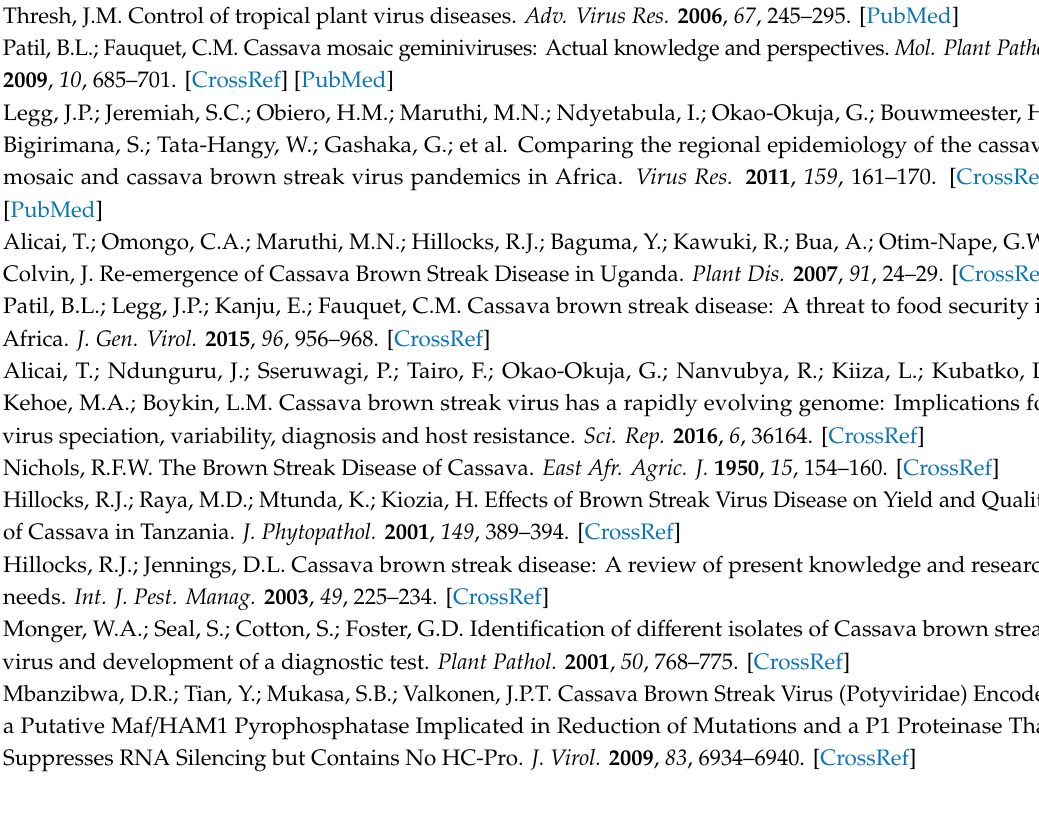
Table S1: Primer sequences used for CBSV and UCBSV detection by qPCR (upper half) and RT-PCR (bottom half) in leaves and storage roots of Ghanaian cassava cultivars. Figure S1: Map showing location of cassava fields from which leaf samples were collected for CBSD screening. Figure S2: PCR screening of eleven selected field-grown cassava cultivars in Ghana. Figure S3: Homology of primers used for RT-PCR screening of cassava cultivars and leaf material collected from farmers’ fields in Ghana. Figure S4: PCR screening of eleven selected cassava cultivars grown in Ghana for cassava mosaic geminiviruses. Table S2: Top-cleft graft transmission of CBSV and UCBSV to farmer-preferred Ghanaian cassava cultivars at 12 weeks. Figure S5: Pearson correlation between CBSD symptom severity and relative CBSV titers in leaves of Ghanaian cassava genotypes. Table S3A: Two-way ANOVA comparing CBSV titers in parental scions and cuttings propagated from scions of Ghanaian cassava cultivars. Table S3B: Šid á k’s multiple comparisons test of CBSV titers in parental scions and cuttings propagated from scions of Ghanaian cassava cultivars. Table S4A: Two-way ANOVA comparing titers of UCBSV in parental scions and cuttings propagated from scions of Ghanaian cassava cultivars. Table S4B: Šid á k’s multiple comparisons test of UCBSV titers in parental scions and cuttings propagated from scions of Ghanaian cassava cultivars. Table S5A: Two-way ANOVA comparing survival rate of cuttings propagated from CBSD-infected Ghanaian cassava cultivars at 12 weeks old. Table S5B: Šid á k’s multiple comparisons test of survival rates of cuttings propagated from CBSD-infected Ghanaian cassava cultivars at 12 weeks old. Figure S6: RT-qPCR quantitation of CBSV and UCBSV in roots of Ghanaian cassava genotypes (6-month-old